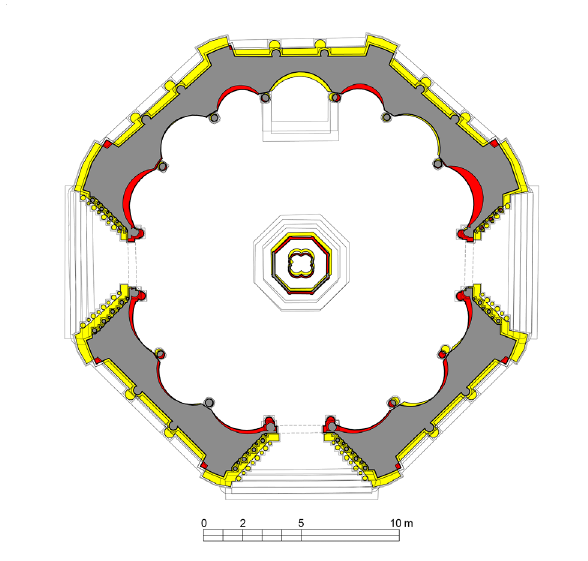
Figure 8. Comparison between the plan of G. Bertoluzzi and that produced by the current survey. In yellow are indicated the parts in which Bertoluzzi places masonry not present in reality. In red are represented actually existing parts, but not indicated in the nineteenth-century drawings.